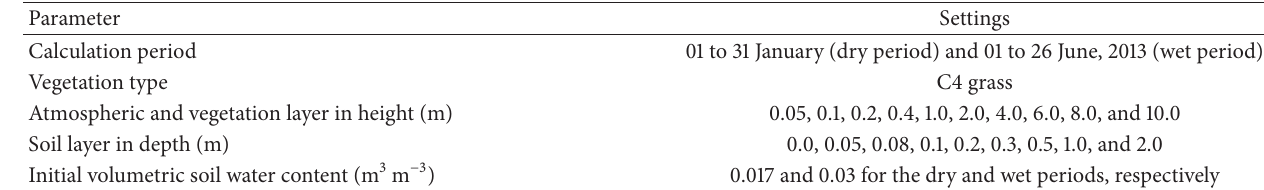
Table 2: General parameters used for the SOLVEG